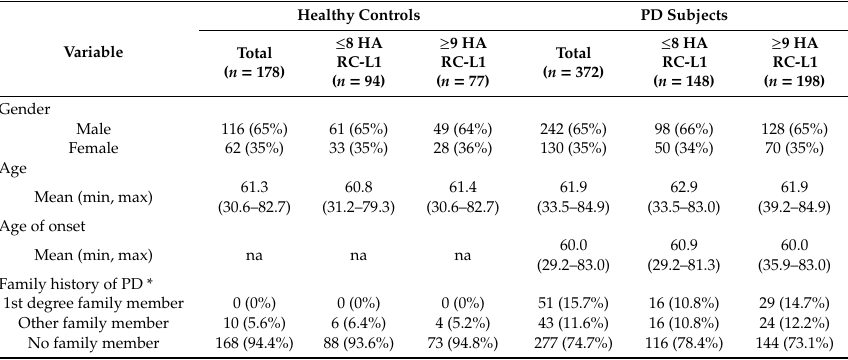
Table 1. Demographics of the Parkinson’s Progression Markers Initiative cohort. The healthy controls and Parkinson’s disease (PD) subjects were divided into two groups those with ≤ 8 and those with ≥ 9 of the RC-L1 present that were identified as polymorphic and highly active (HA). Genotypes were not available at all 16 RC-L1 loci for all individuals; therefore, the total number of combined individuals from the ≤ 8 and ≥ 9 HA RC-L1 groups is lower than the cohort total. * One PD subject with family history data